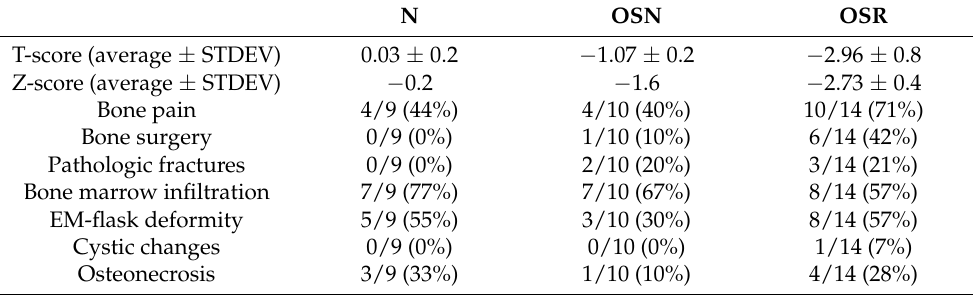
Table 1. The clinical features of bone disease in GD (Gaucher disease) cohorts: no bone complications (N), osteopenia (OSN), and osteoporosis (OSR). N OSN OSR T-score (average ± STDEV) 0.03 ± 0.2 − 1.07 ± 0.2 − 2.96 ± 0.8 Z-score (average ± STDEV) − 0.2 − 1.6 − 2.73 ±